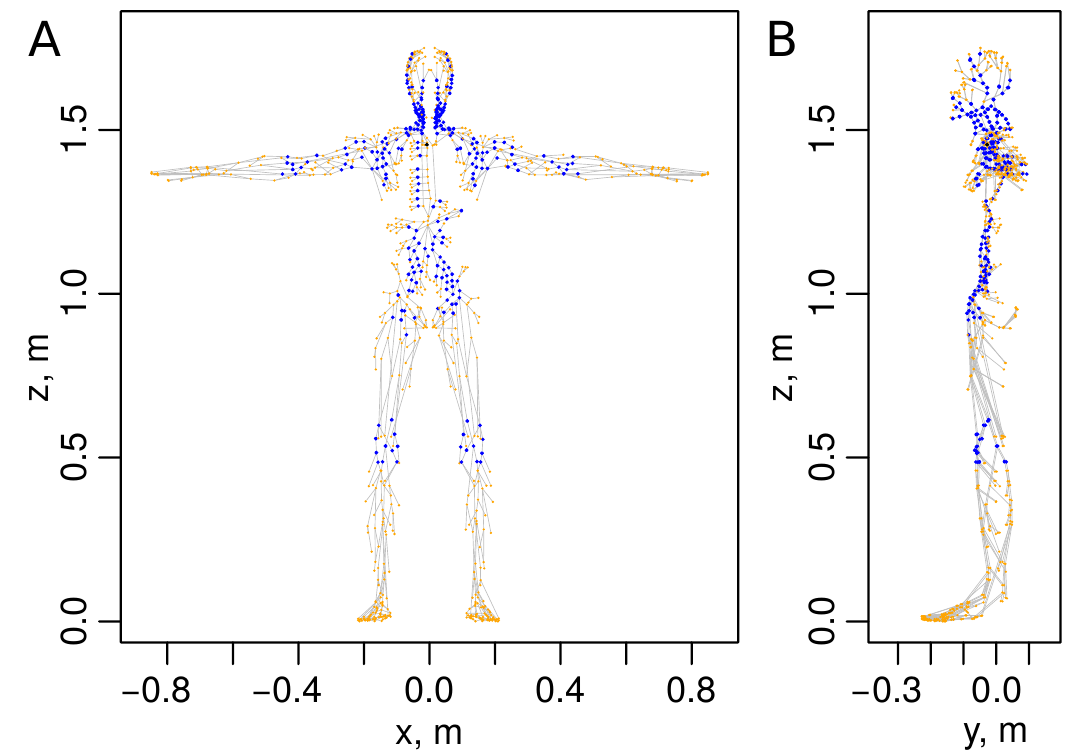
Figure 2. Graph of a human lymphatic system based on anatomical Plasticboy data [5] with 996 vertices and 1117 edges (graph files are provided in Supplementary Materials). ( A ) Face- and ( B ) side views. Blue colored vertices represent 272 lymph nodes. The black vertex corresponds to the output